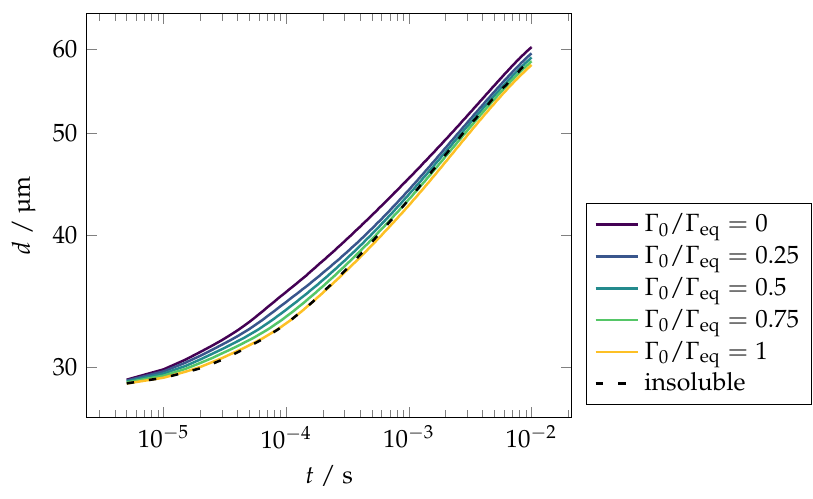
Figure 8. Influence of the initial surfactant concentrations on the wetting behavior.